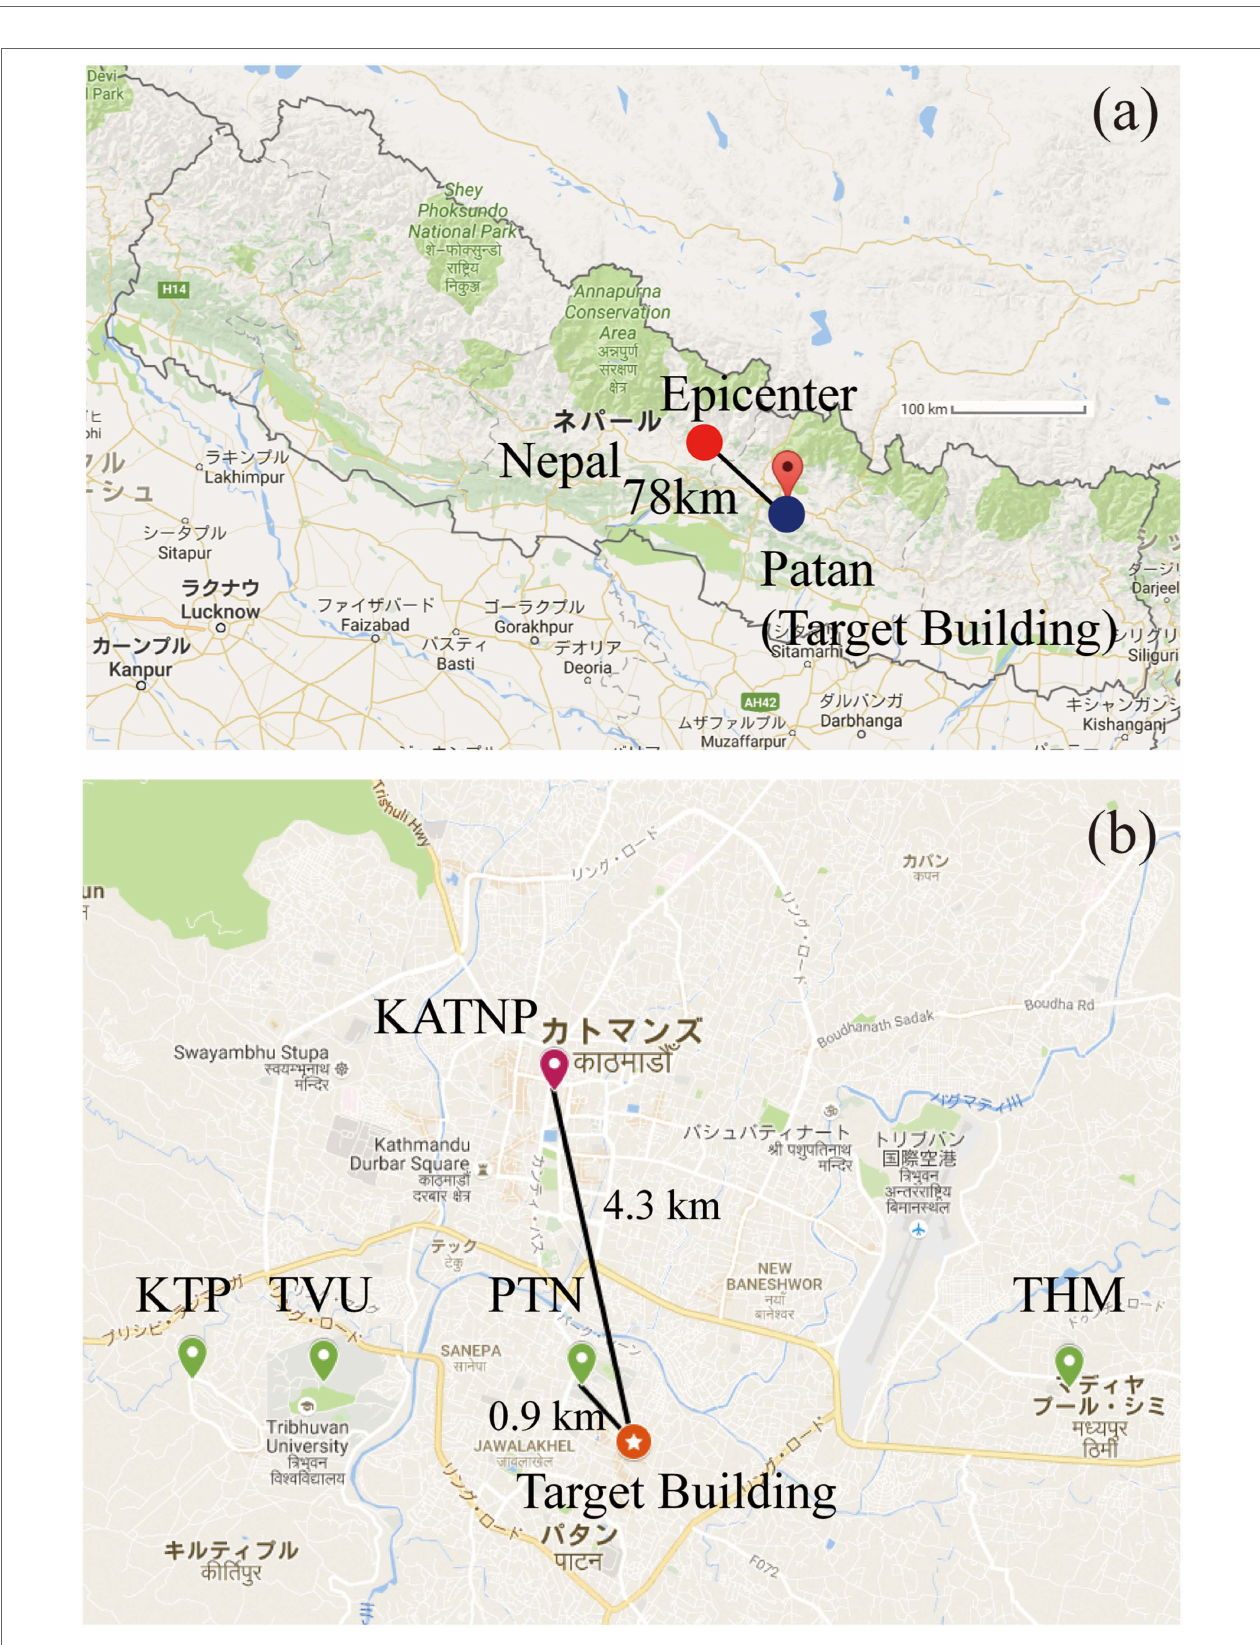
FIGURE 1 | Locations of the epicenter, observation points, and target building (Google Maps, 2016). (A) Location of the epicenter and the target building. (B) Location of the target building and the observation points.